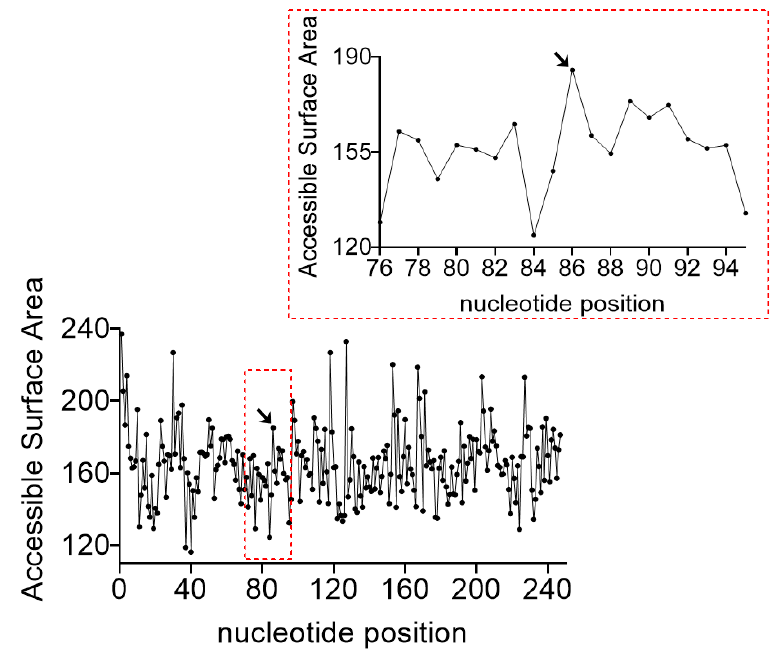
Figure 7. Accessible surface area of ASBVd(–) nucleotides as determined using the RNASol Web- Server. The inset is the enlarged graph around the cleavage site, denoted with an arrow.